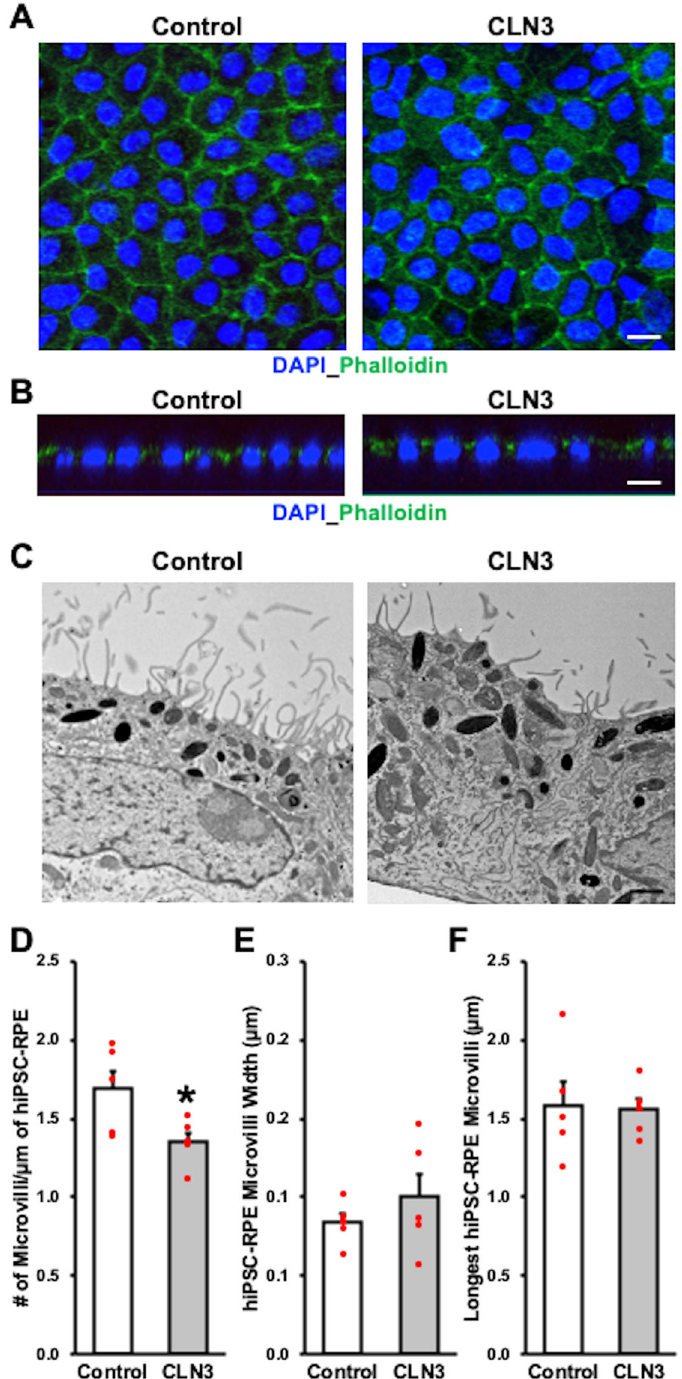
Fig. 6 Decreased apical RPE microvilli density in CLN3 disease hiPSC-RPE cultures. A , B Representative confocal microscopy images after immunocytochemical analyses showing similar localization of F-actin as visualized by phalloidin staining in control and CLN3 disease hiPSC-RPE cells (scale bar = 10 µ m) ( n = 3). Of note in panel B , orthogonal view of hiPSC-RPE monolayer shows expected apical localization of phalloidin relative to cell nuclei (DAPI) in control and CLN3 disease hiPSC-RPE. C – F Representative transmission electron microscopy (TEM) images ( C , scale bar = 1 µ m) and corresponding quantitative analyses showing decreased apical RPE microvilli density ( D , p = 0.042), but similar apical-RPE microvilli width ( E , p = 0.38), and length ( F , p = 0.88) in control versus CLN3 disease hiPSC-RPE cells ( n = 5). Two-tailed unpaired Student ’ s t -test performed for all statistical analysis. * p < receptor, avß5 integrin (Supplementary Fig. 6), the POS engulf- ment receptor, MERTK (Supplementary Fig. 6), and RPE apical photoreceptor cell loss and retinal degeneration 29,68 . It is note- worthy that despite reduced POS phagocytosis by CLN3 disease microvilli regulator, EZR (Fig. 1E), were unchanged between hiPSC-RPE cells, the protein expression of the POS binding control and CLN3 disease hiPSC-RPE cells. CLN3 has been